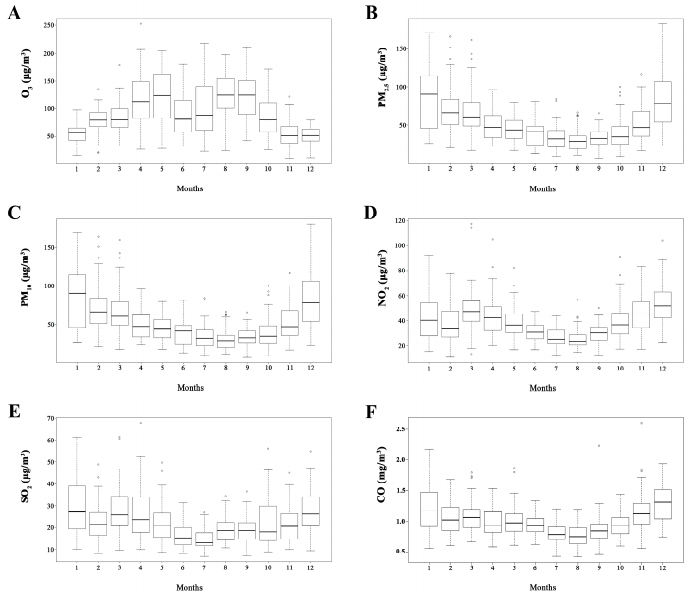
Figure 1. Monthly distribution patterns of ambient pollutants in Changzhou, 2015–2016. ( A ) O 3 indicates ozone; ( B ) PM 2.5 , particulate matter that is ≤ 2.5 µm in diameter; ( C ) PM 10 , particulate matter that is ≤ 10 µm in diameter; ( D ) NO 2 , nitrogen dioxide; ( E ) SO 2 , sulfur dioxide; ( F ) CO, carbon monoxide.